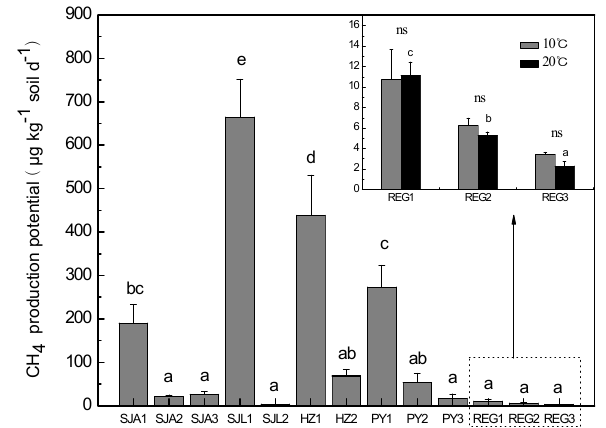
Fig. 2. CH 4 production potential of vertical profile soil slurries in the Sanjiang Plain C. angustifolia (SJA1 = 0–20cm, SJA2 = 20– 40cm, SJA3 = 40–60cm) and C. lasiocarpa (SJL1 = 0–30cm, SJL2 = 30–60cm) marshes, Hongze wetland (HZ1 = 0–20cm, HZ2 = 20–40cm), Poyang wetland (PY1 = 0–10cm, PY2 = 10– 20cm, PY3 = 20–40cm) and Ruoergai peatland (REG1 = 0–10cm, REG2 = 10–20cm, REG3 = 20–40cm). Vertical bars denote